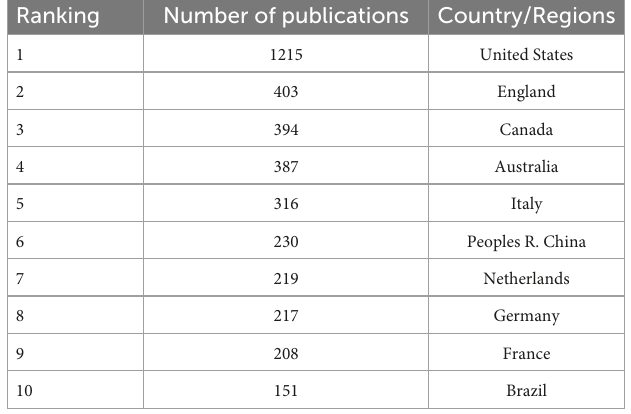
TABLE 2 The top 10 countries/regions in the number of children’s DCD research papers published. Ranking